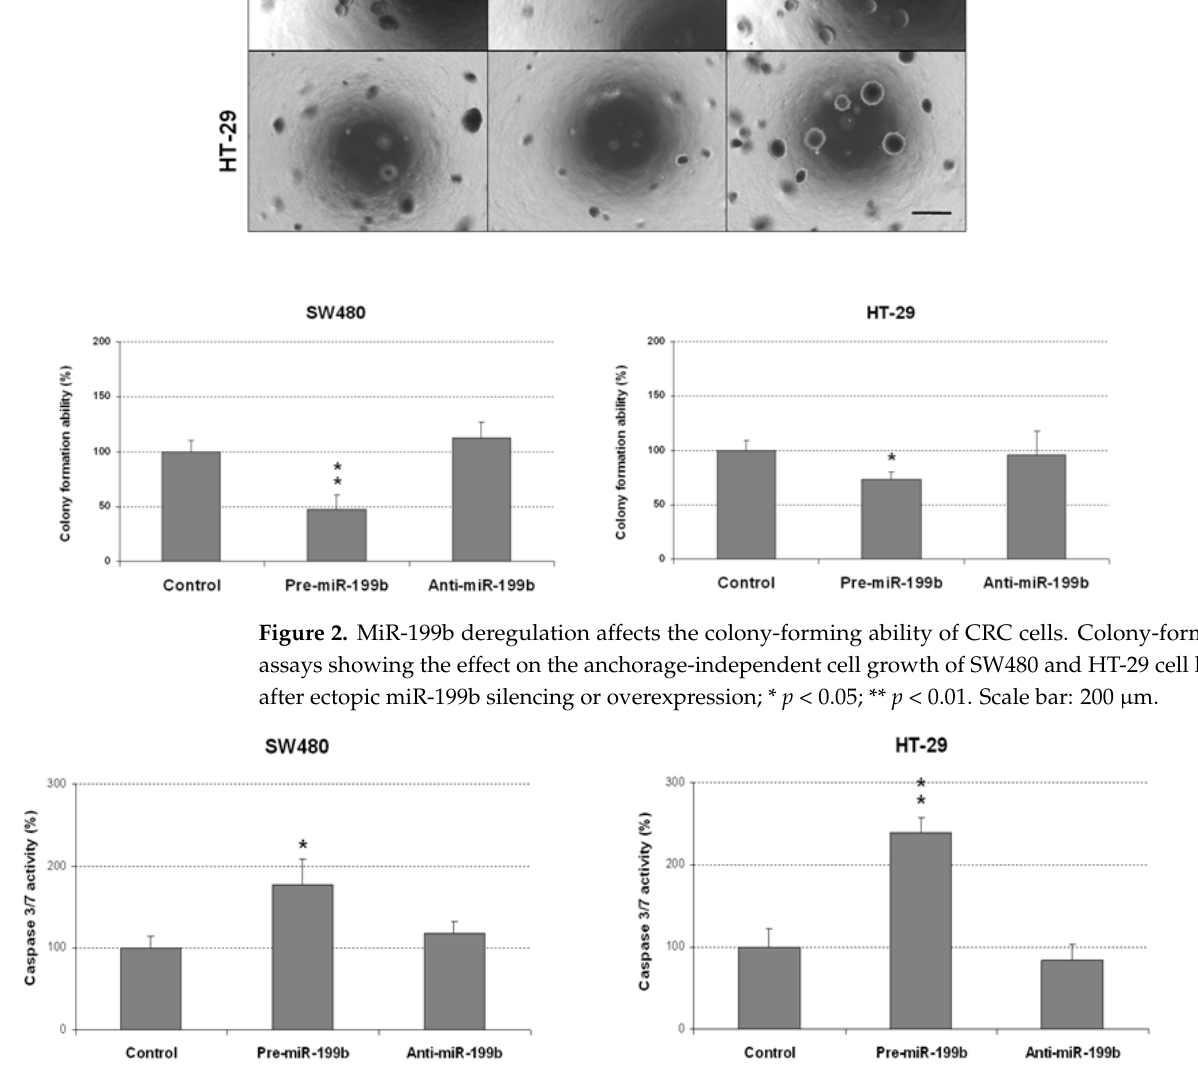
Figure 3. MiR-199b induces apoptosis in CRC cells. Caspase-3/7 activity assay showing levels of apoptotic SW480 and HT-29 cells after transfection with pre-miR-199b and anti-miR-199b; * p < 0.05; ** p < 0.01. We further explored the biologic effects of miR-199b deregulation in CRC by ana- lyzing the colonosphere formation ability of SW480 and HT-29 cells. Notably, miR-199b overexpression led to significant decreased colonosphere formation ability in both